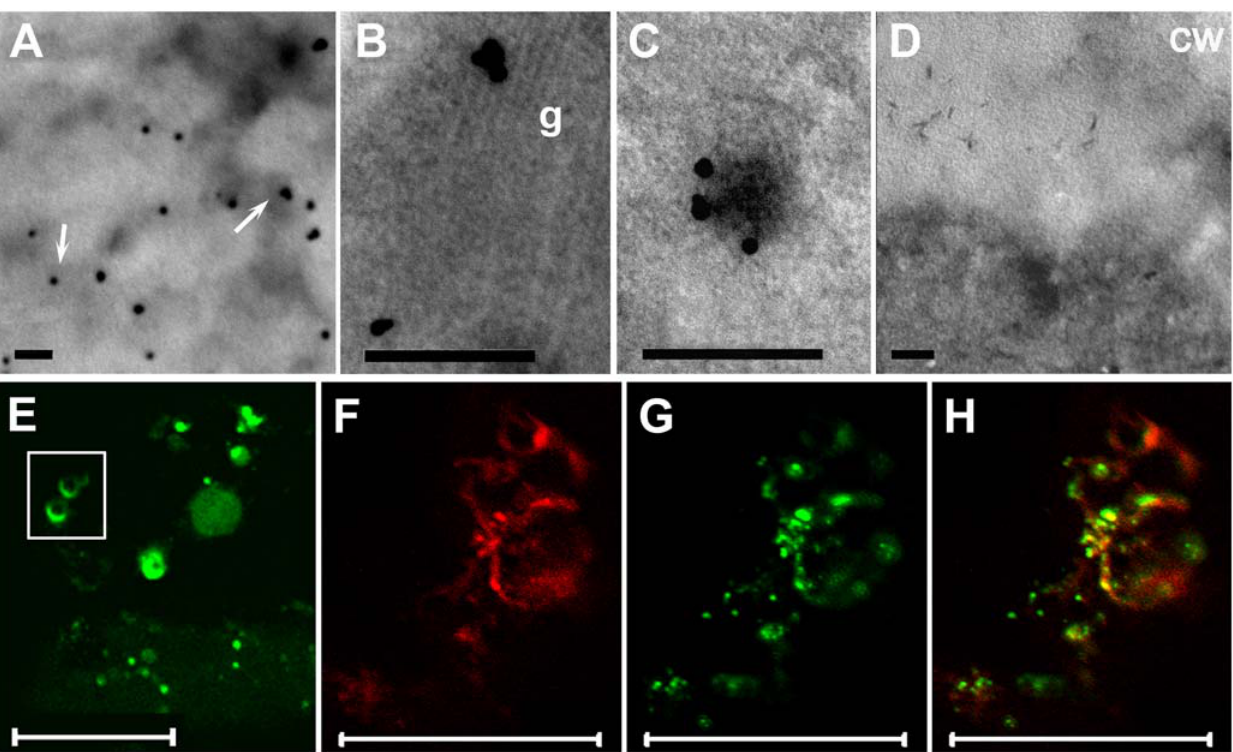
antibody. Gold particles accumulate on ER (A) Golgi apparatus (B) and PVC (C). No specific labeling was found in the control image (D). ER is indicated with arrows. Bars, 0.2 m m. (E) VER2-GFP fusion signals with ring structures. (F)–(H) Colocalization of VER2-GFP with VSR At . The anti-VSR-marked